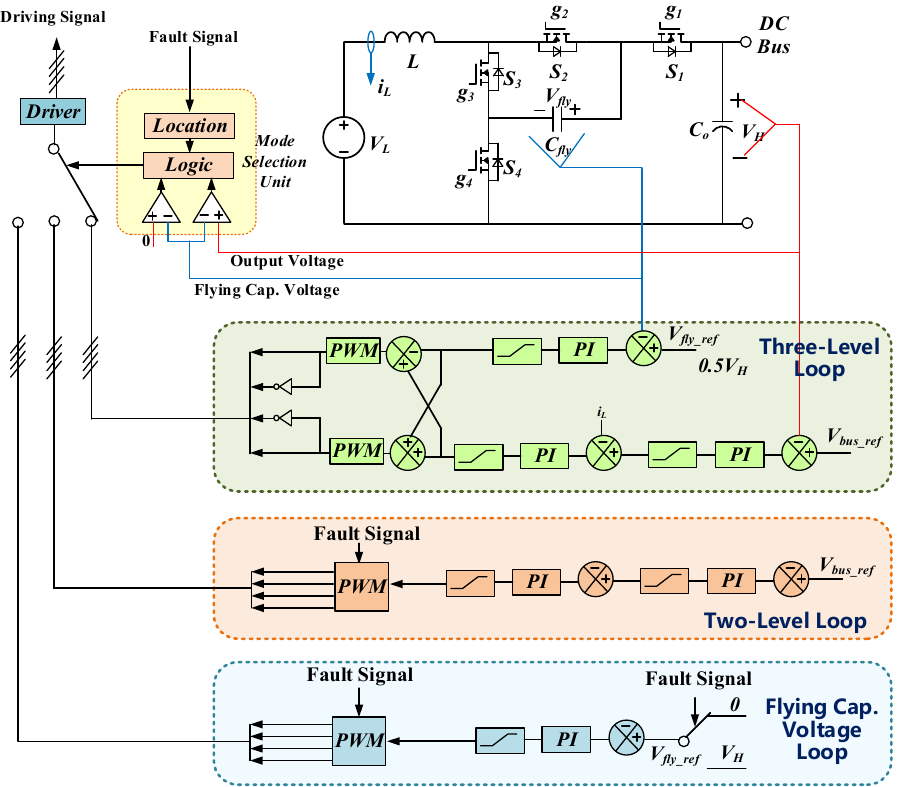
Figure 2. Control scheme of the fault-tolerant strategy for flying capacitor DC/DC converter. The fault-tolerant strategy consists of three loops, including a three-level voltage reg- ulation loop, a flying capacitor voltage loop, and a two-level voltage regulation loop. Output voltage and flying capacitor voltage are two control targets for the three-level voltage regulation loop.